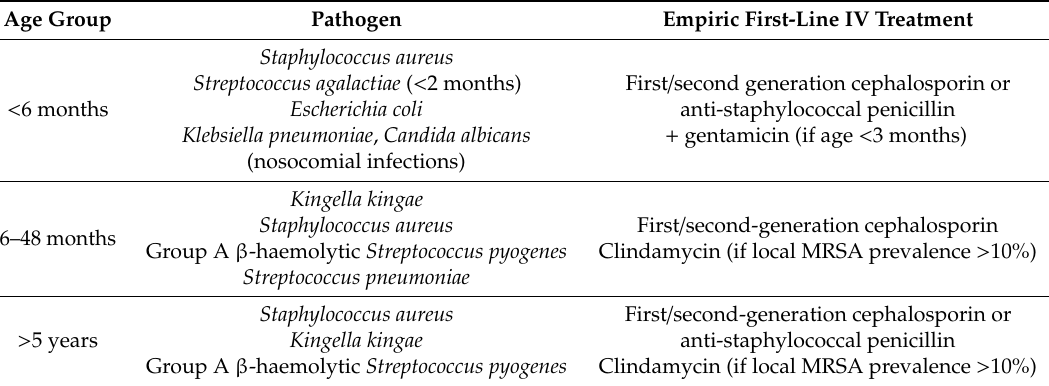
Table 1. Most common pathogens causing bone and joint infection in children and recommended first-line intravenous (IV) empiric treatment of di ff erent age